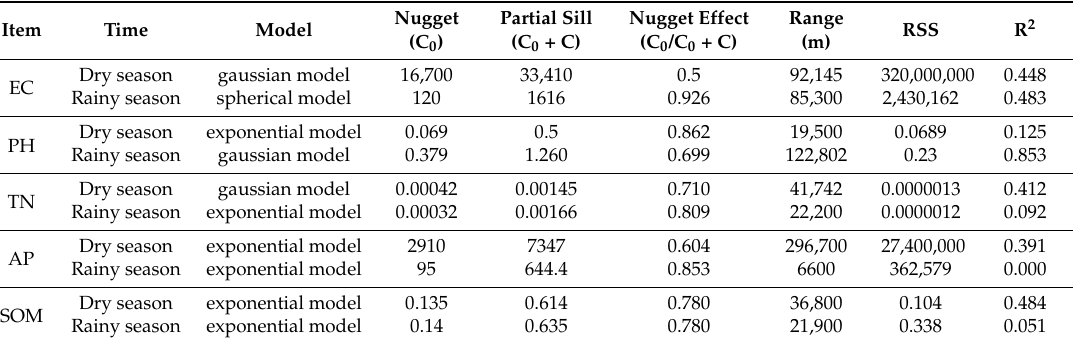
Figure 6. Variograms of AP ( a ), EC ( b ), pH ( c ), SOM ( d ) and TN ( e ) in the rainy season of Mun River Basin. Table 4. Semi-variance parameters of soil